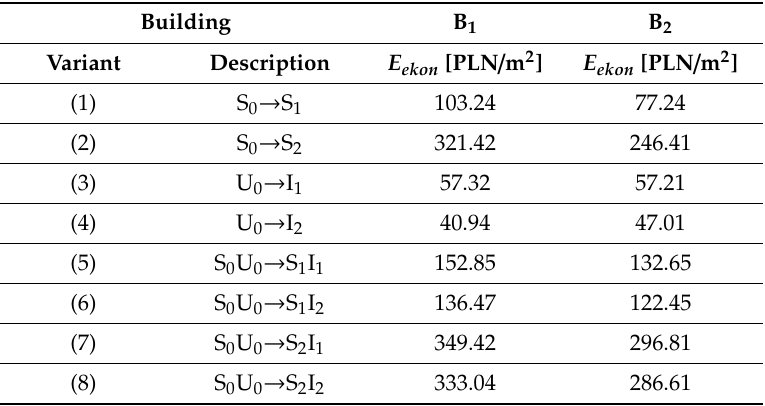
Table 12. Economic costs of